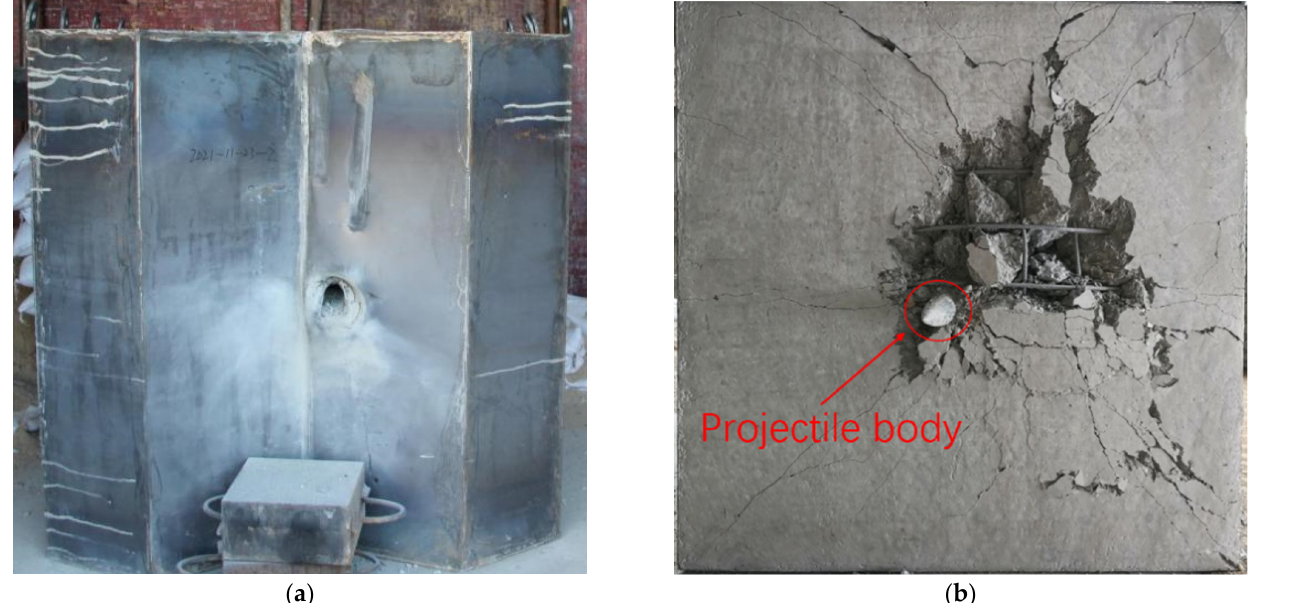
Figure 11. Photographs of the target plate after impact (without diamond-shaped moving target). ( a ) Front side. ( b ) Back side.